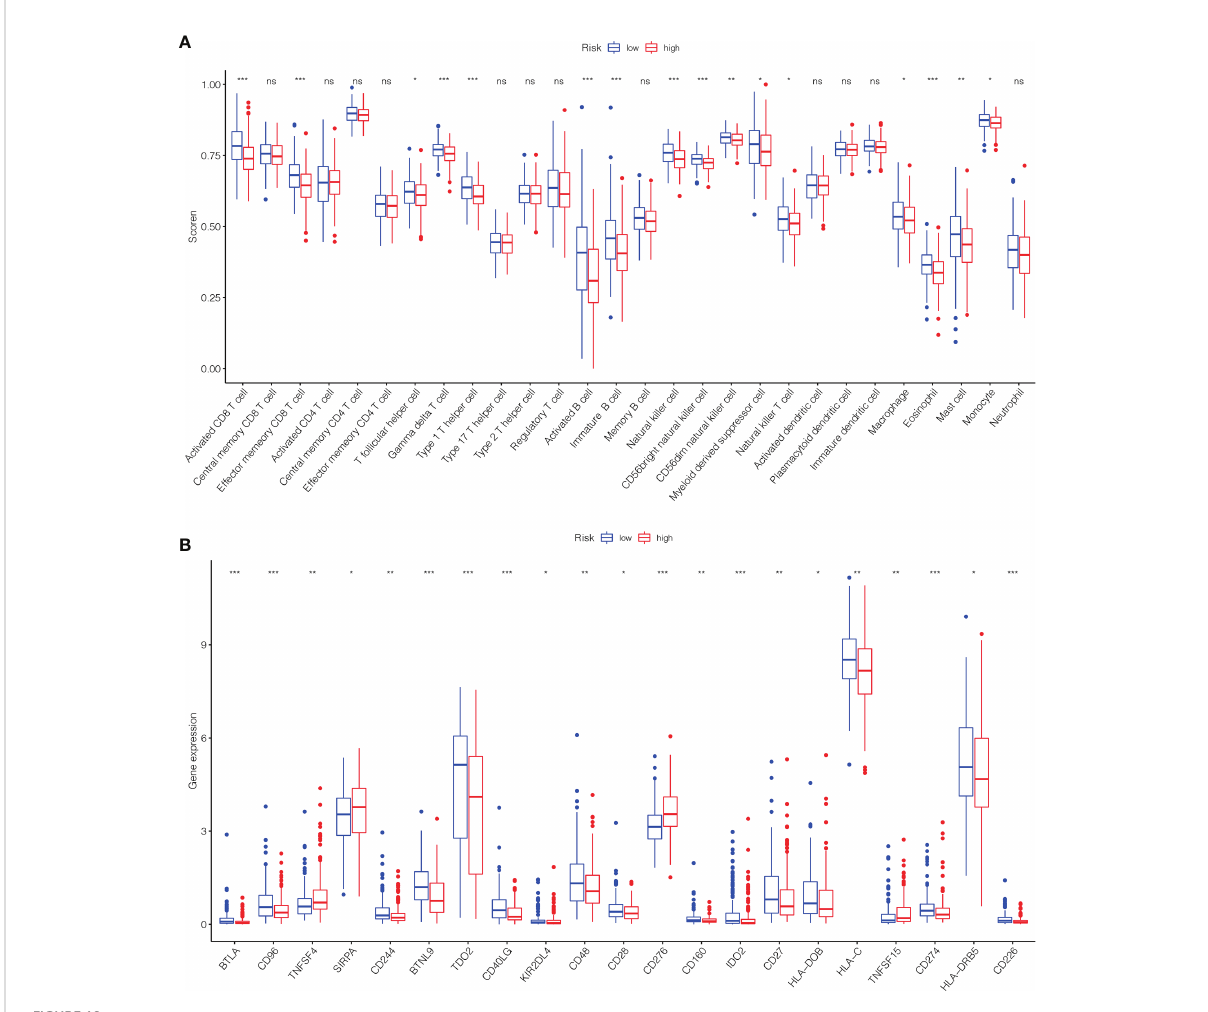
FIGURE 10 The scores of immune in fi ltrating cells (IIC) and immunological checkpoint in H- and L- risk groups. (A) The in fi ltration levels of 28 immune cells in H- and L- risk groups. (B) The expression levels of 21 immune checkpoint in H- and L- risk groups. * P < 0.05; ** P < 0.01; *** P < 0.001; ns, no signi fi